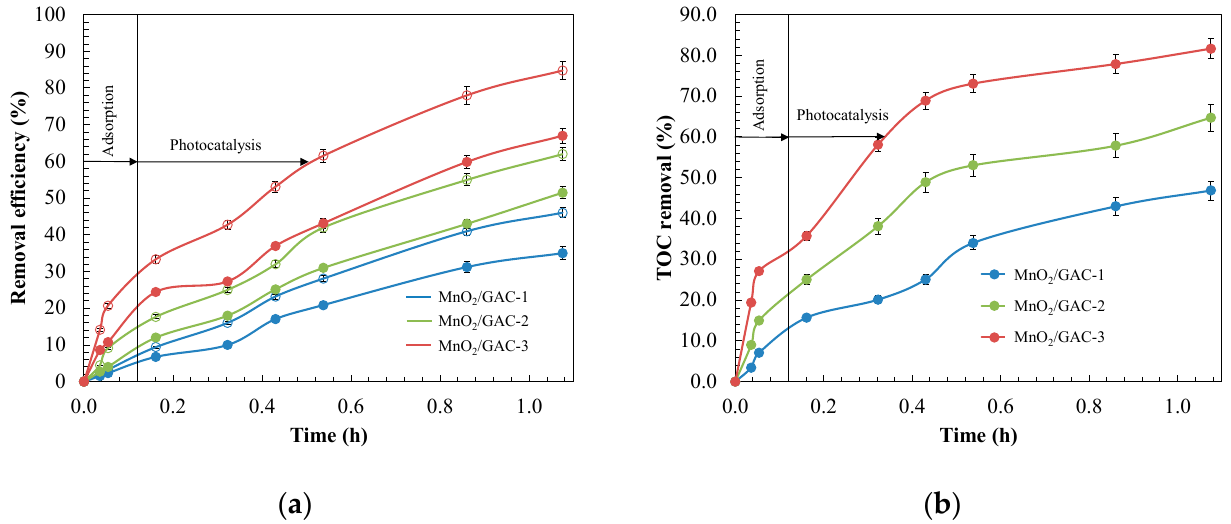
Figure 11. Comparison of the catalytic activity of MnO 2 /GAC composites. Evolution of the: ( a ) primary degradation of ANI ( ○ ) and BTH ( ● ); ( b ) mineralisation. Experimental conditions: C 0 = 12.0 mg L − 1 ; pH = 9.0; m CAT = 0.9 g L − 1 ; Irradiation dose = 155.8 W m − 2 .